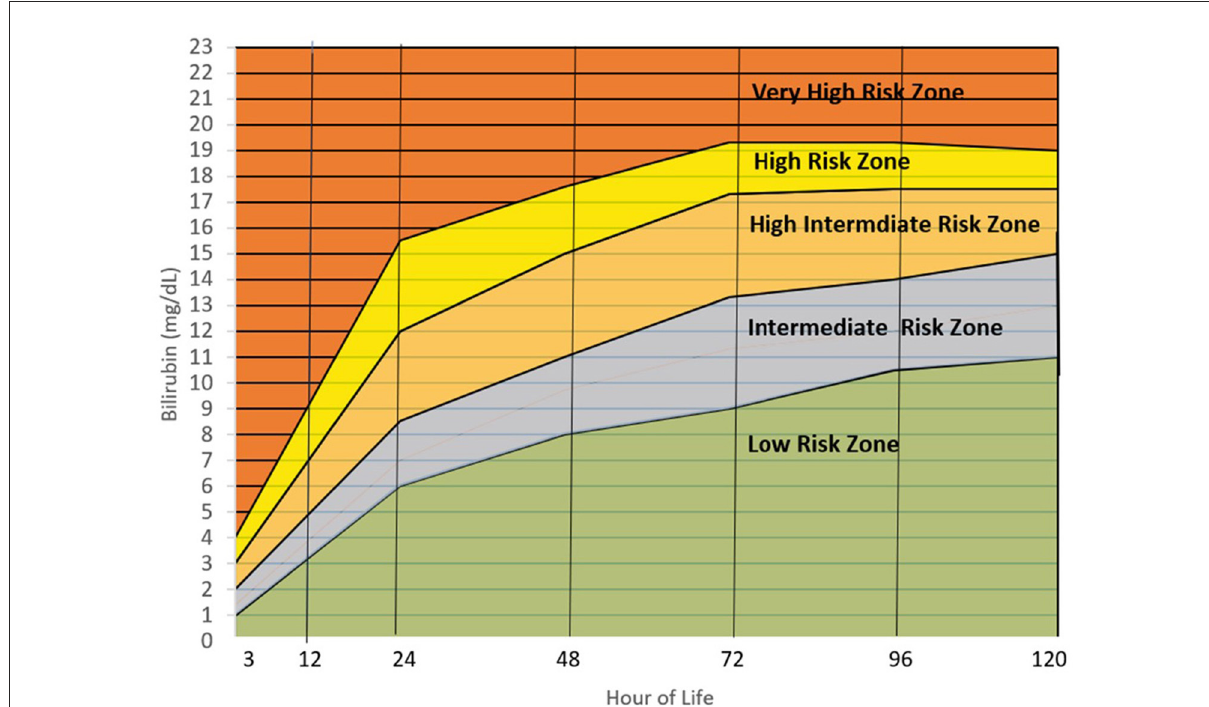
FIGURE4 Filipino bilirubin nomogram showing the different risk zones. Low Risk Zone or LRZ (0– < 25th percentile)-Infants with bilirubin levels falling in this zone have a < 5% risk of developing significant hyperbilirubinemia (SH) ( > 95th percentile or High-risk zone). The infants may be discharge and followed up after 48–72 hours, especially if they were discharged < 72 hours of life. Intermediate Risk Zone or IRZ (25th– < 75th percentile)-Infants with bilirubin levels in the IRZ have a < 5% risk of subsequent SH but have a 15–20% risk of shifting to the High-Risk Intermediate Zone (HIRZ), especially if the bilirubin determination was done in the first 48 hours. For infants with risk factors, bilirubin may be repeated after 24 hours. High Intermediate Risk Zone or HIRZ ( > 75th– < 95th percentile)-Infants with bilirubin levels in the HIRZ, should be further observed and have a repeat of bilirubin determination after 24 hours. In the presence of risk factors such as hemolytic disease, young gestational age, weight loss ( > 10%), sepsis and others, phototherapy may be started. High Risk Zone or HRZ (95th– < 99th percentile)-Infants with bilirubin levels at the HRZ have significant hyperbilirubinemia and require initiation of phototherapy. Very High Risk Zone or VHRZ ( ≥ 99th percentile)-Infants with bilirubin levels at the VHRZ have severe hyperbilirubinemia and require immediate intensive phototherapy while preparing for exchange transfusion. Risk factors identified by the AAP and significant in this study are: Gestational age < 38 weeks, inadequate nursing (significant weight loss), male sex, ABO/RH incompatibility, G6PD deficiency, East Asian race, cephalhematoma/bruising, previous